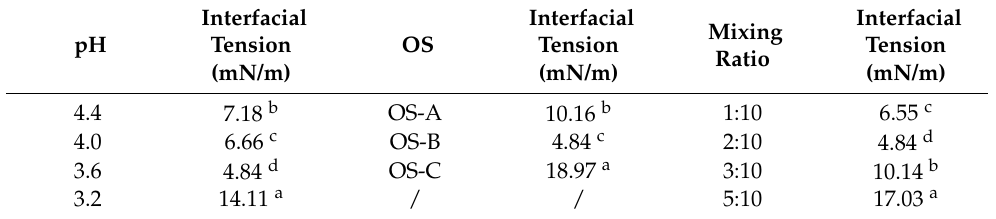
Table 3. Interfacial tension of OS/ β -lg complex particles obtained at different pHs, mixing ratios, and DSs of oxidized